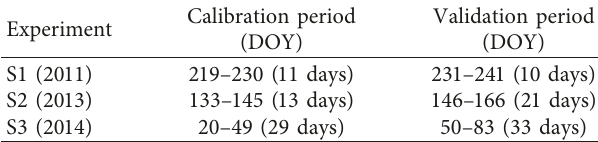
Table 2: Calibration and validation periods of the three campaigns.